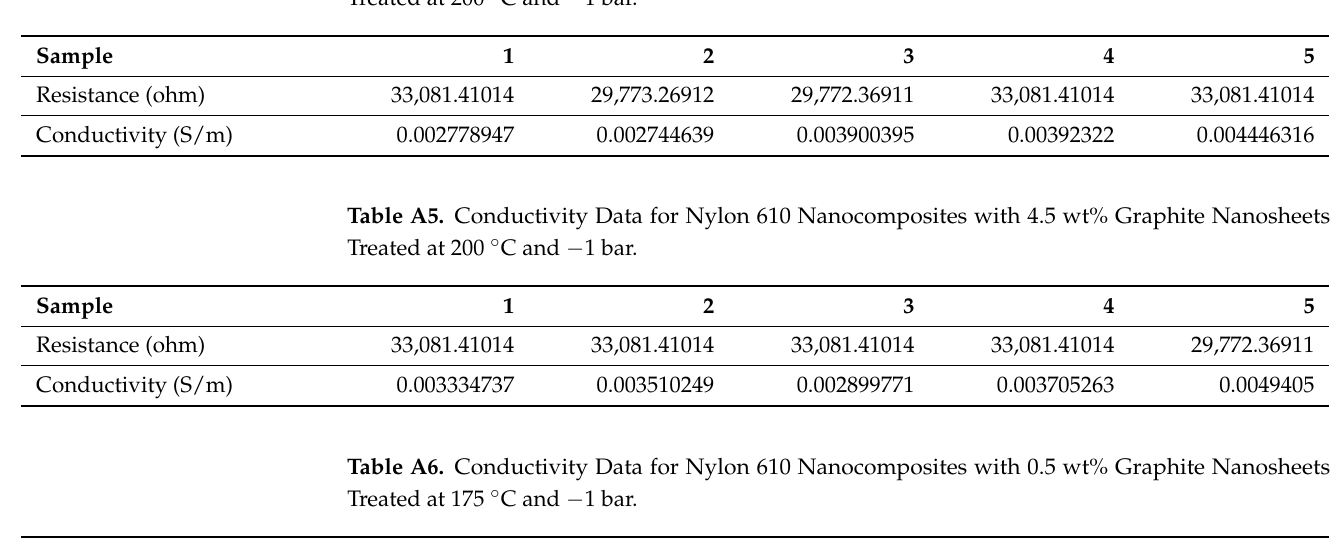
Table A4. Conductivity Data for Nylon 610 Nanocomposites with 3.5 wt% Graphite Nanosheets Treated at 200 ◦ C and − 1 bar.